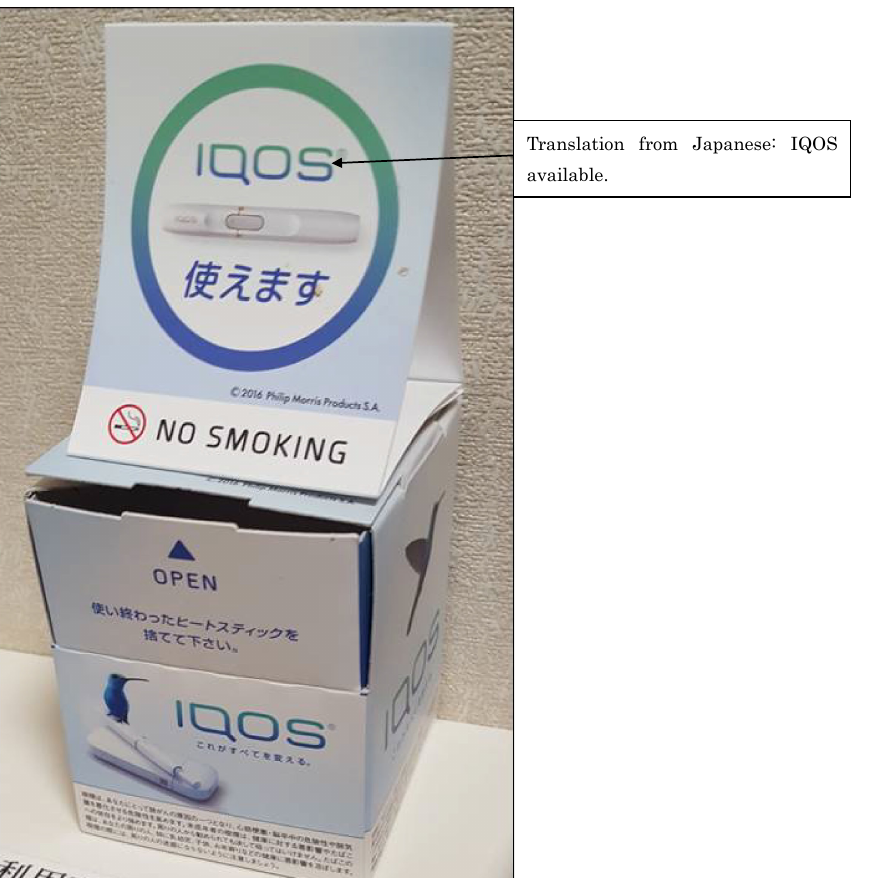
Figure 1. An example of a new image strategy for heated tobacco products (HTPs): A dust box used for HTP sticks in a hotel room prohibiting traditional combustible cigarette use. It displays “ No smoking ” and “ IQOS is available ” (photo by JA at a hotel in